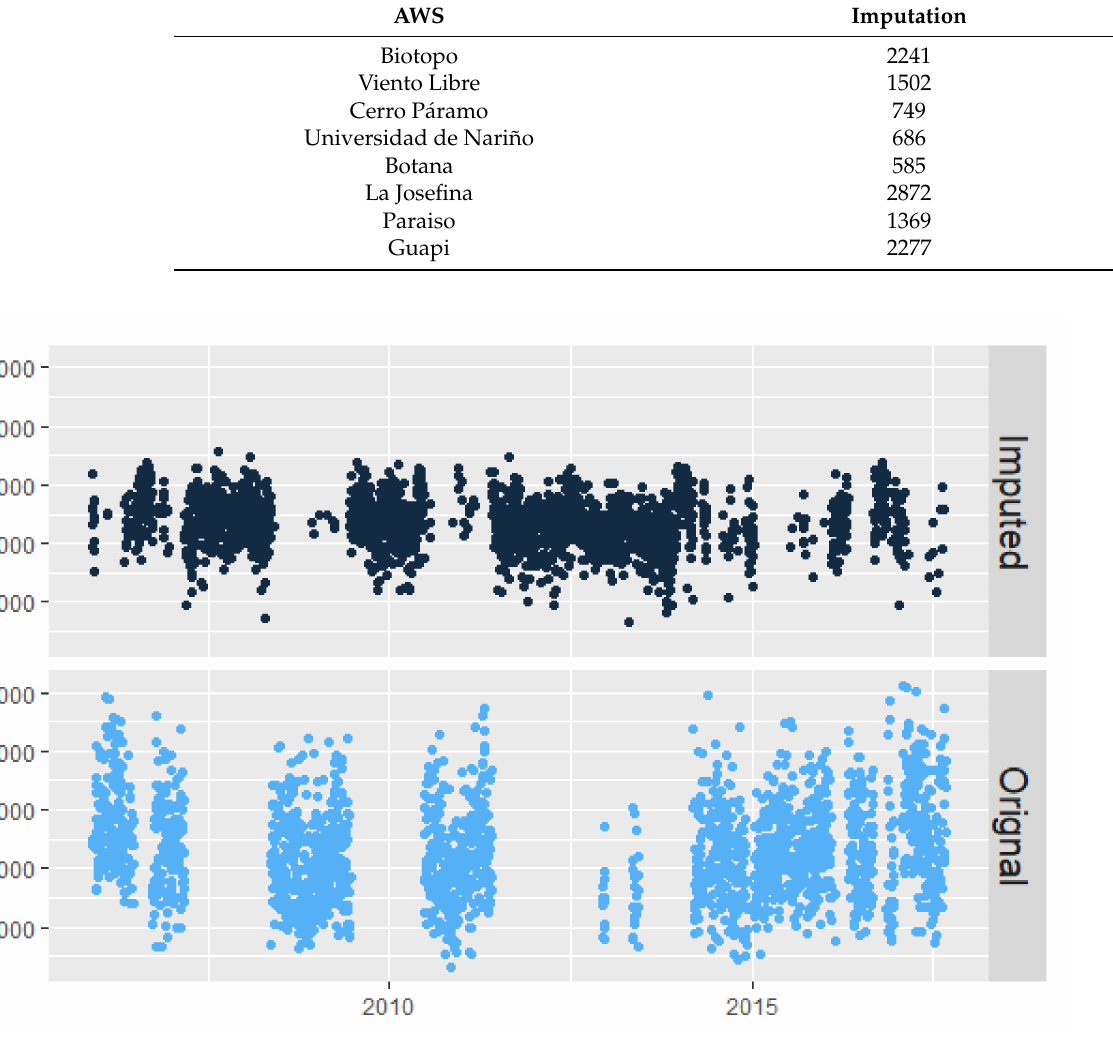
Figure 12. Biotopo imputation. The dark blue points are the estimated values using air temperature information, and the light blue points are the measured